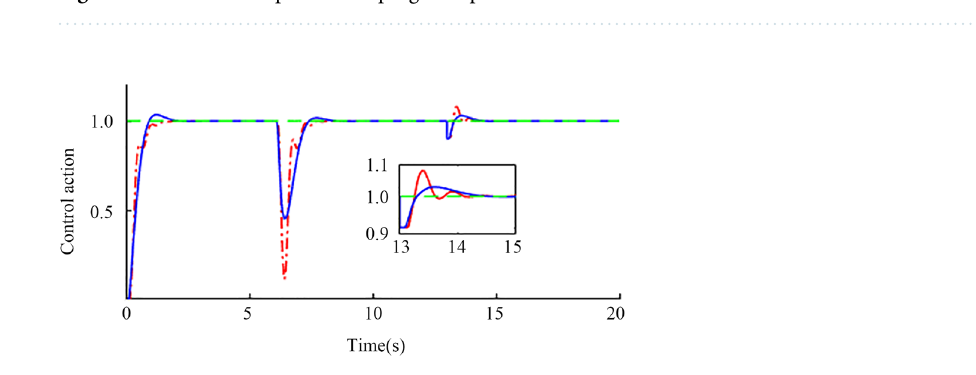
Figure 12. Nominal response at step signal input.